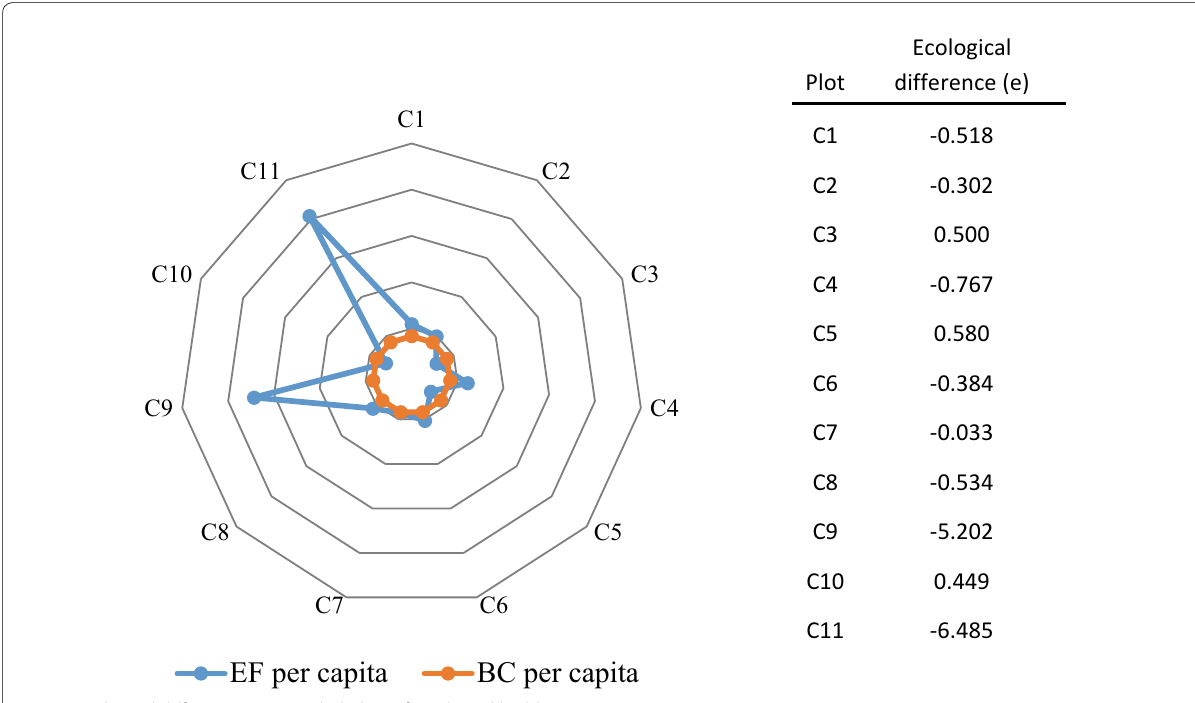
Fig. 4 Ecological difference per sampled plots of residential building